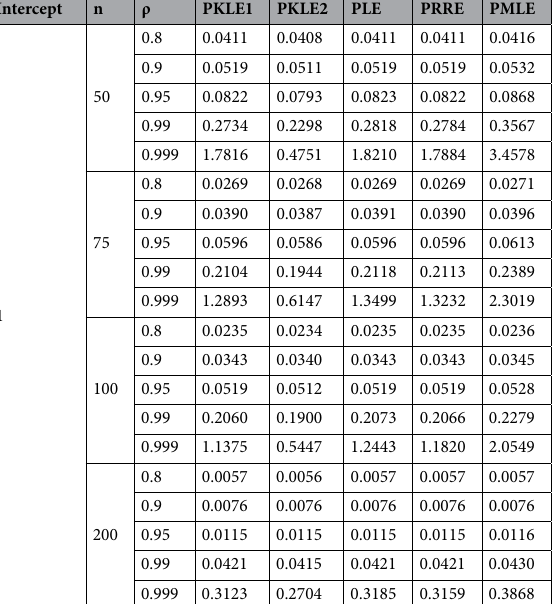
Table 3. Simulated MSE when p = 4 and intercept = 1.